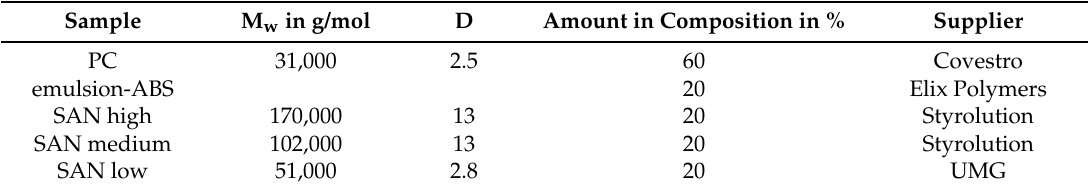
Table 1. Properties of blend components.